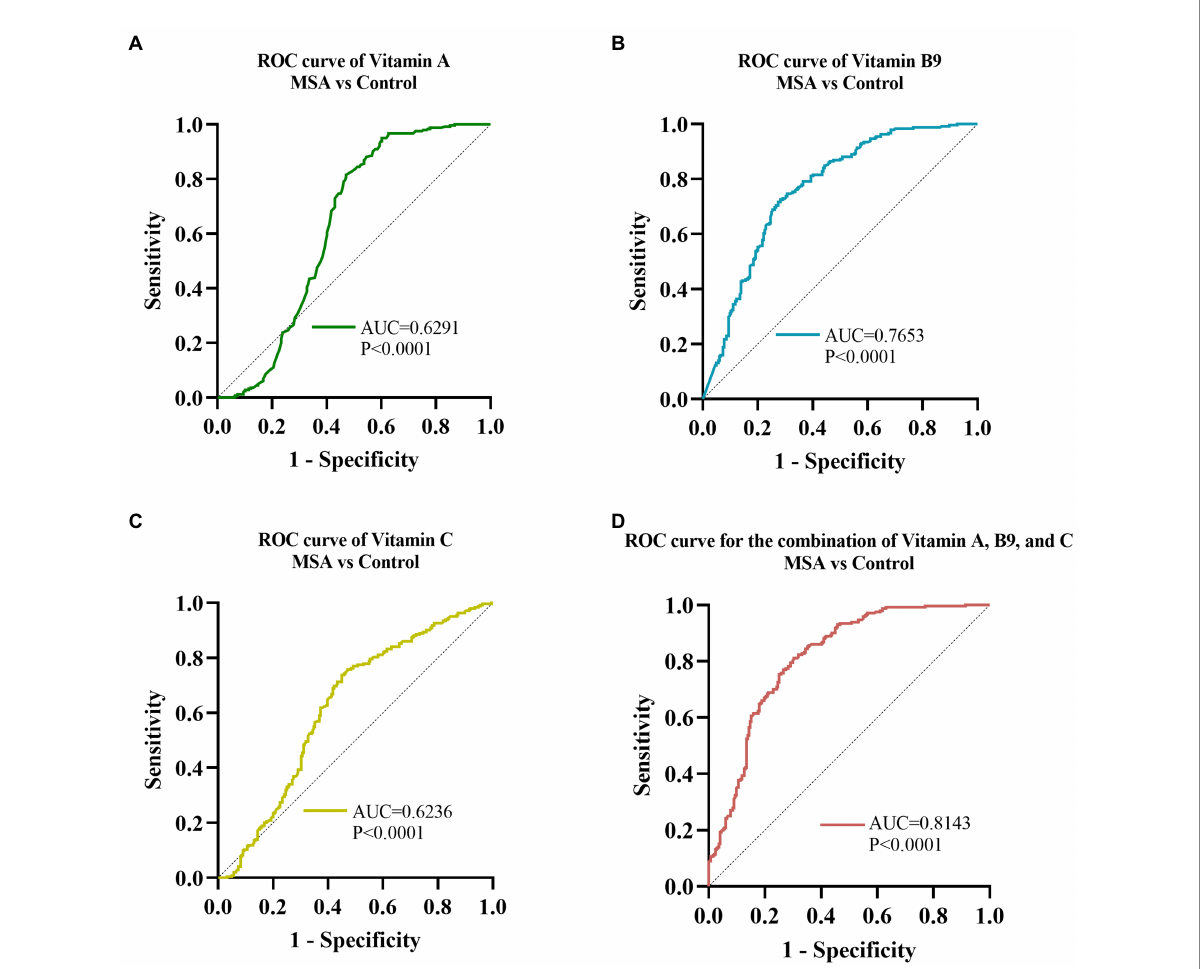
FIGURE 4 ROC curves to evaluate the utility of serum levels of vitamin for the discrimination of MSA patients from healthy controls. The AUC of ROC curves for (A) vitamin A, (B) vitamin B9, and (C) vitamin C were 0.6291 (95% CI: 0.5769 to 0.6813, p < 0.0001), 0.7653 (95% CI: 0.7229 to 0.8077, p < 0.001), and 0.6236 (95% CI: 0.5732 to 0.6739, p < 0.0001), respectively. The AUC of (D) combination of vitamin A, B9, and C was 0.8143 (95% CI: 0.7762 to 0.8523, p <